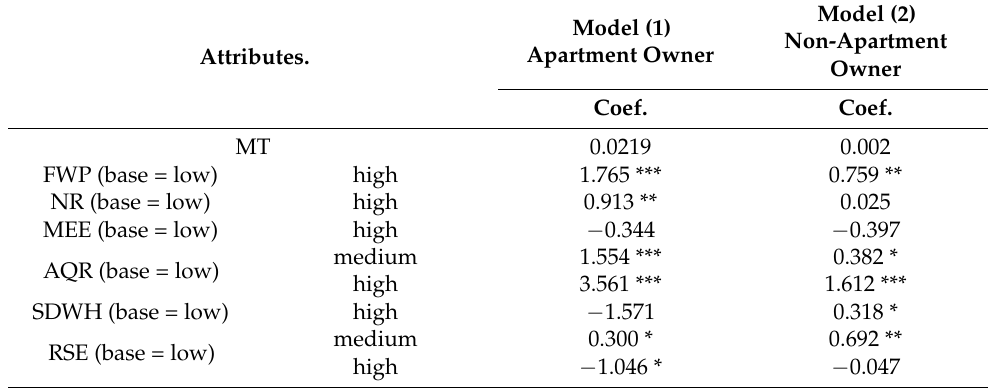
Table 13. Comparison of WTP values for apartment owners and non-apartment